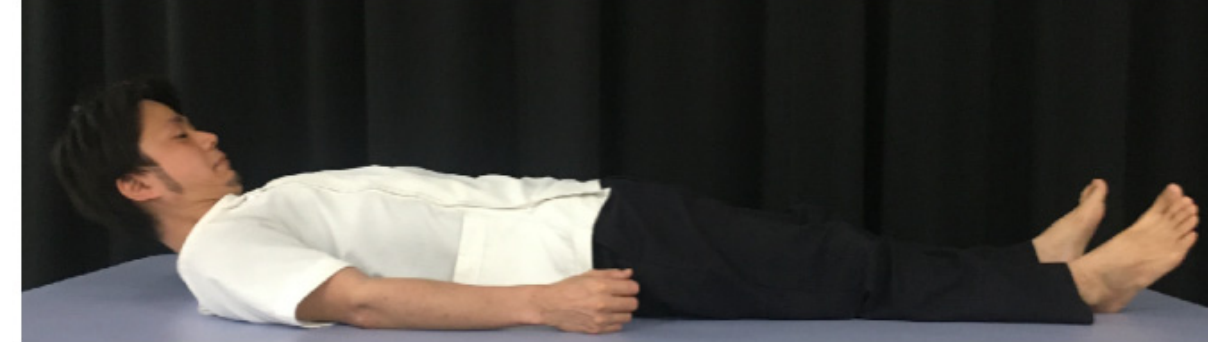
Figure 2. Shaker exercise. The head is kept raised in the supine position.